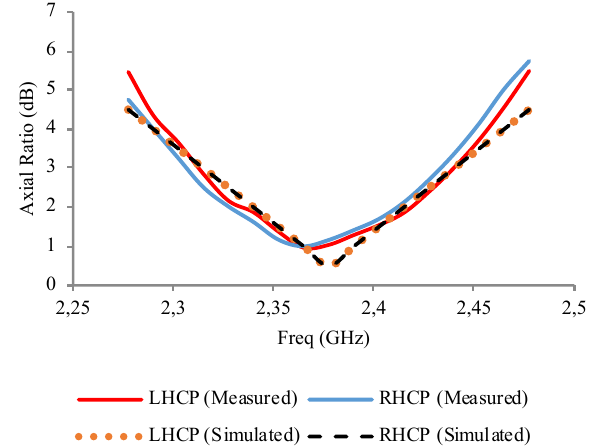
Figure 10: Variation of axial ratio (dB) with respect to operating frequency band (GHz)